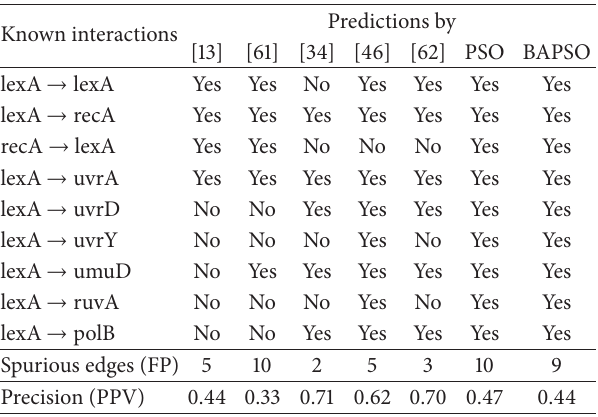
Table 4: Comparison with contemporary research [46] for the E. coli